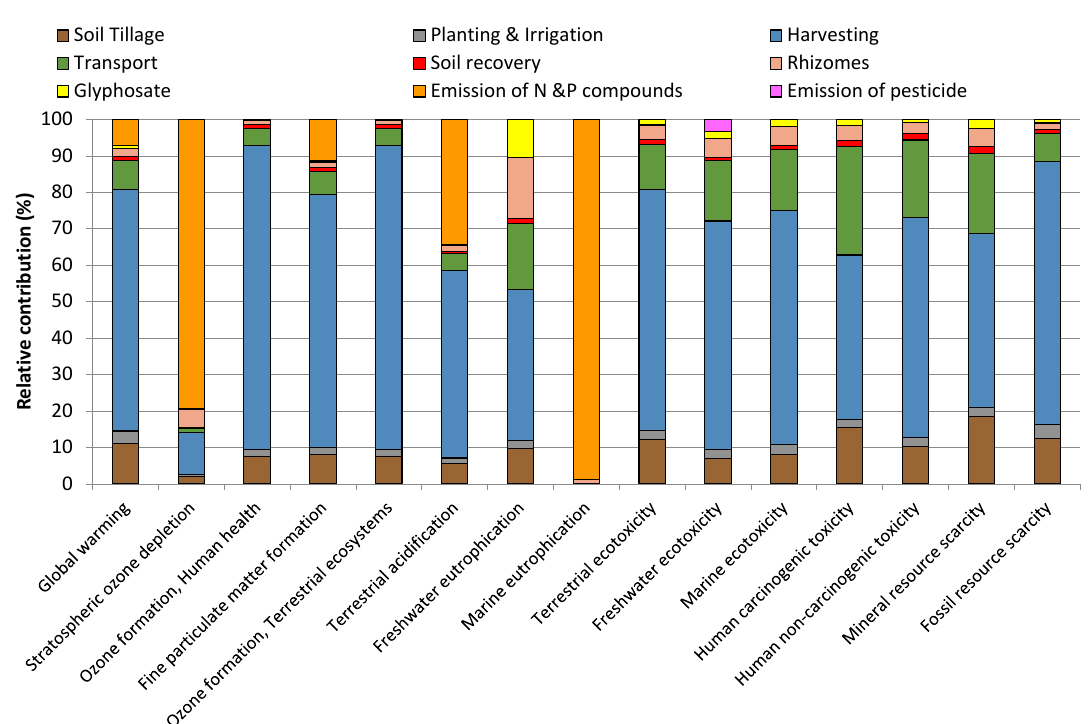
Figure 2. Contribution analysis for miscanthus cultivation.